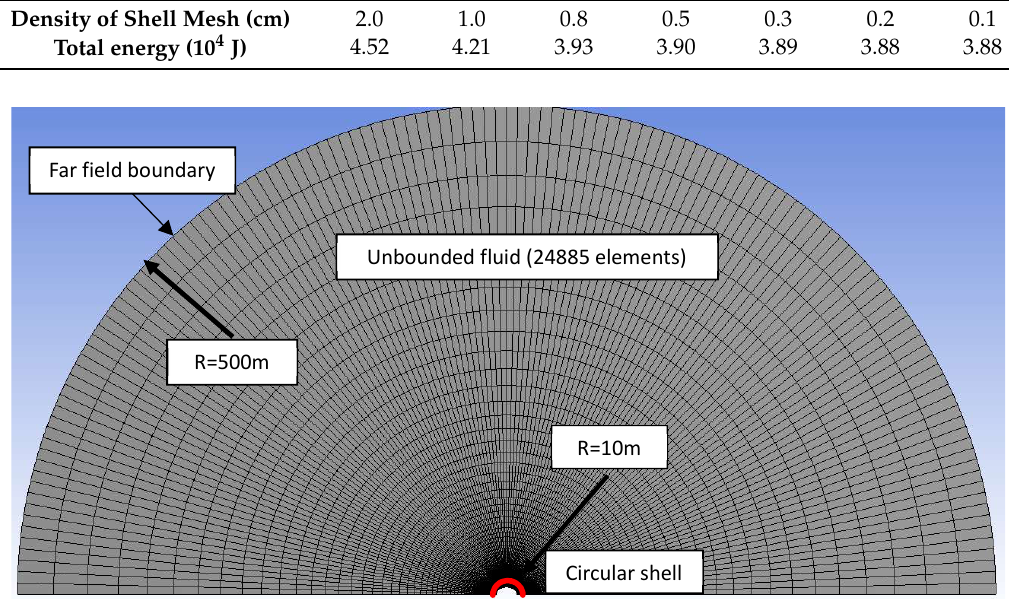
Table 1. The total energy with different densities of mesh.